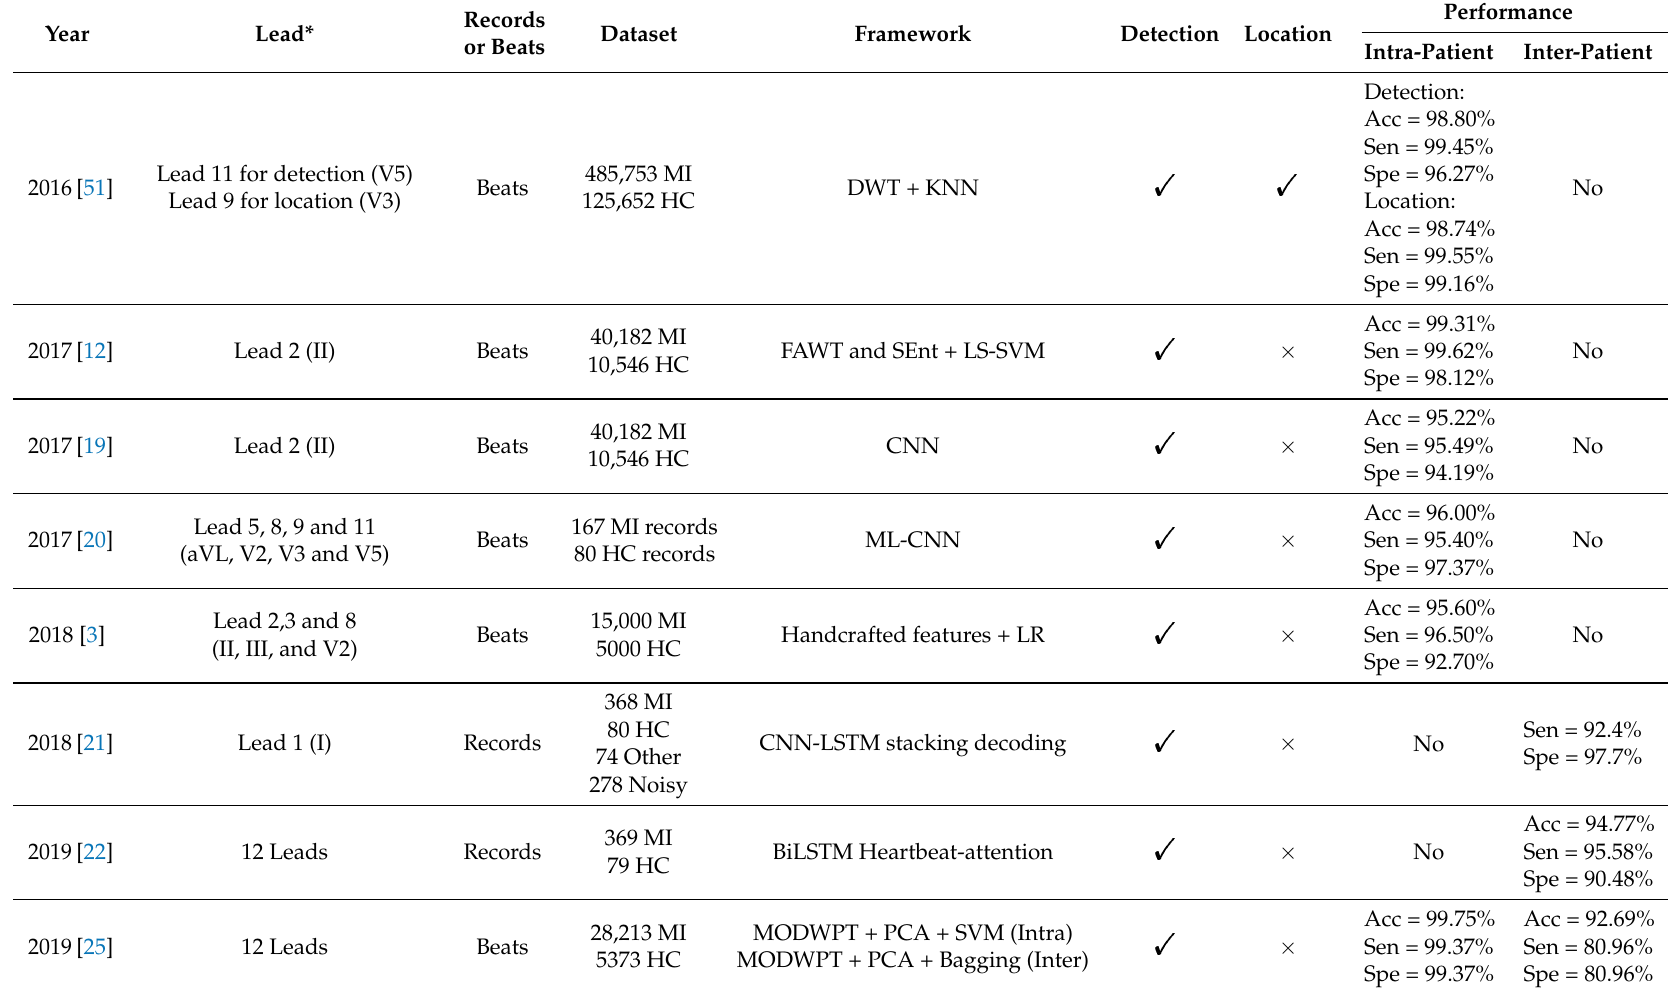
Table 6. Comparison of frameworks for MI detection and location by ECG signals on the PTB